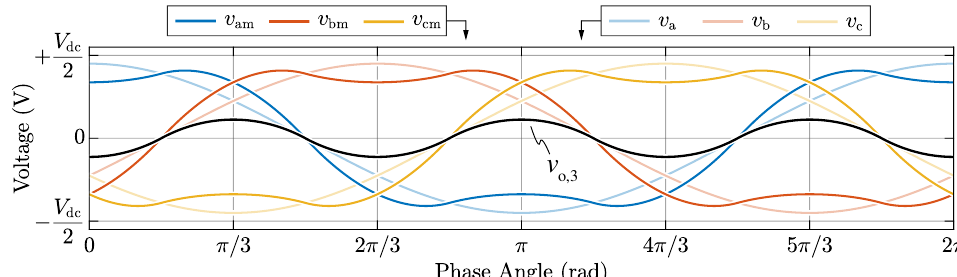
Figure 9. Zero-sequence voltage injection v o,3 according to the zero mid-point current modulation (ZMPCPWM) with M = 0.9 and ϕ = 0. The reference phase voltages v a , v b , v c and the resulting bridge-leg voltages v am , v bm , v cm are shown for completeness.